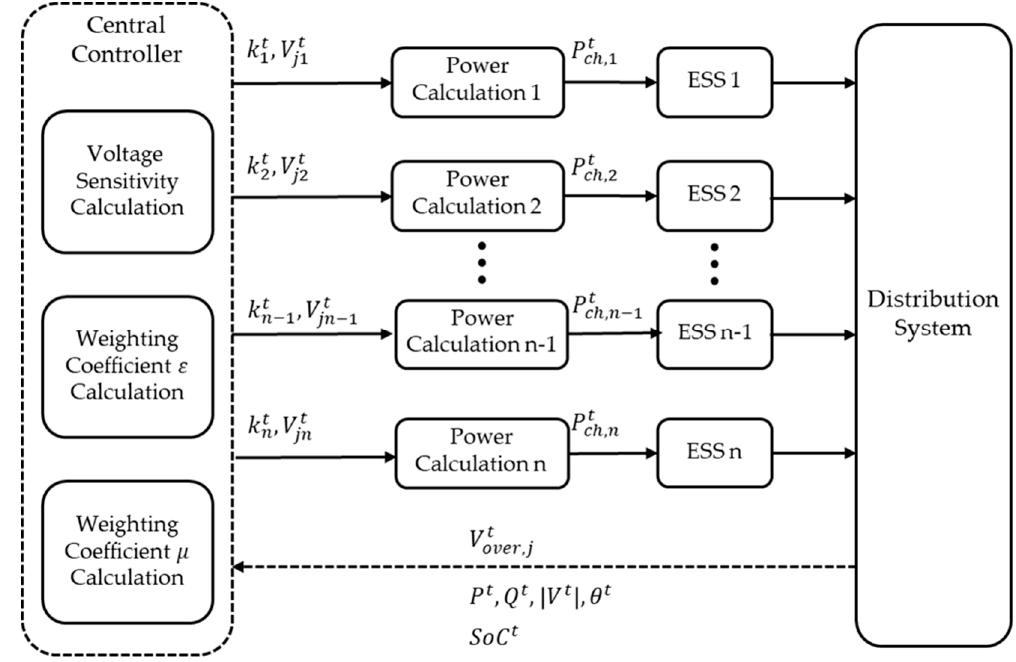
Figure 6. The control structure of the voltage control algorithm of the distributed ESS.